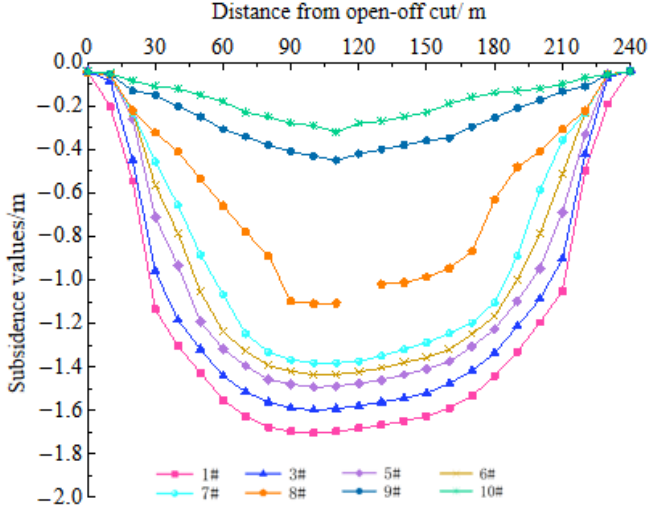
Figure 6. Rock displacement subsidence curve.